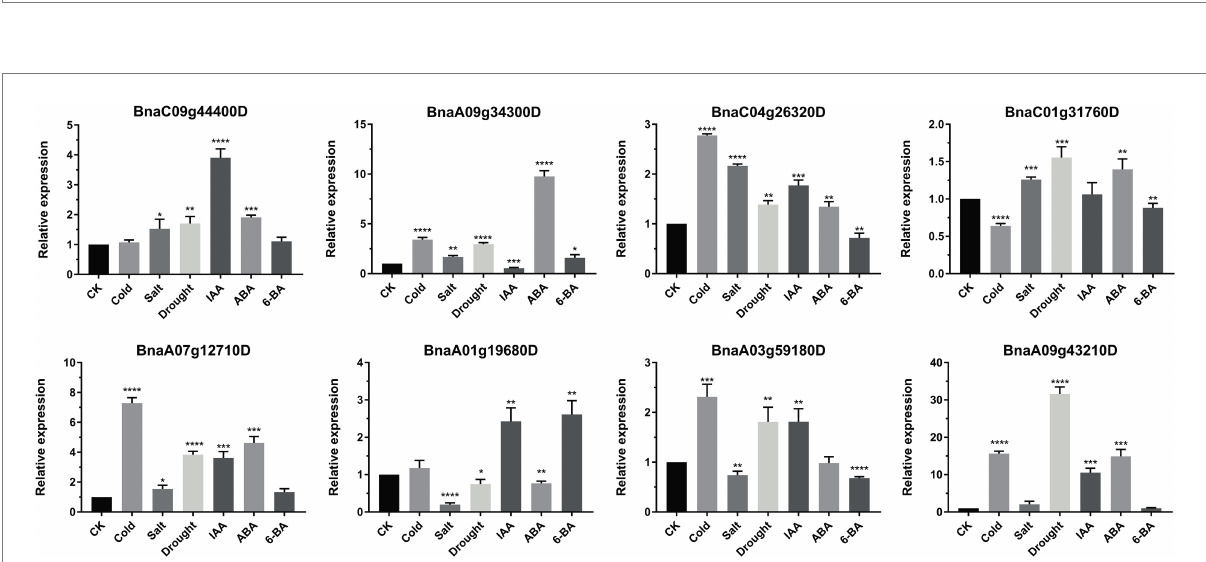
FIGURE 11 Expression levels of eight BnSHI/STYs under different abiotic stresses and hormone treatments. The selected BnSHI/STYs were normalized concerning the reference gene (Actin). The X -axis corresponds to different abiotic stress treatments and hormone treatments. The values on the Y -axis represent the mean ± SD of three biological replicates. Asterias on vertical bar shows significant difference at * p < 0.05, ** p < 0.01, *** p < 0.001, **** p <